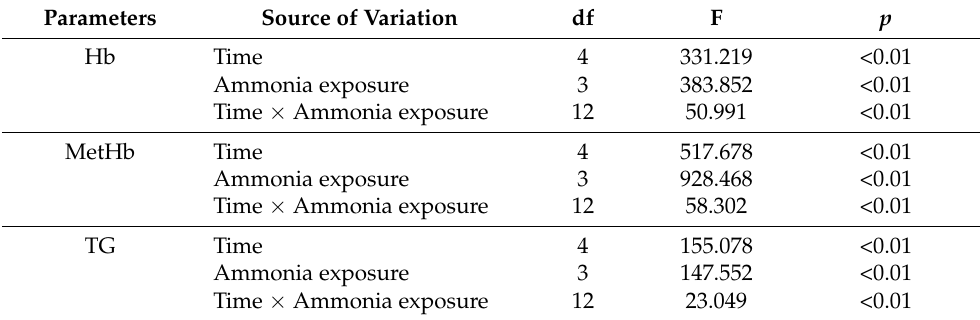
Table 1. The results of the interaction between time and/or nitrite exposure on the levels of hemato- logical biochemical parameters, the activity of antioxidant enzyme, and the immune-related indicator using the two-way ANOVA method are shown